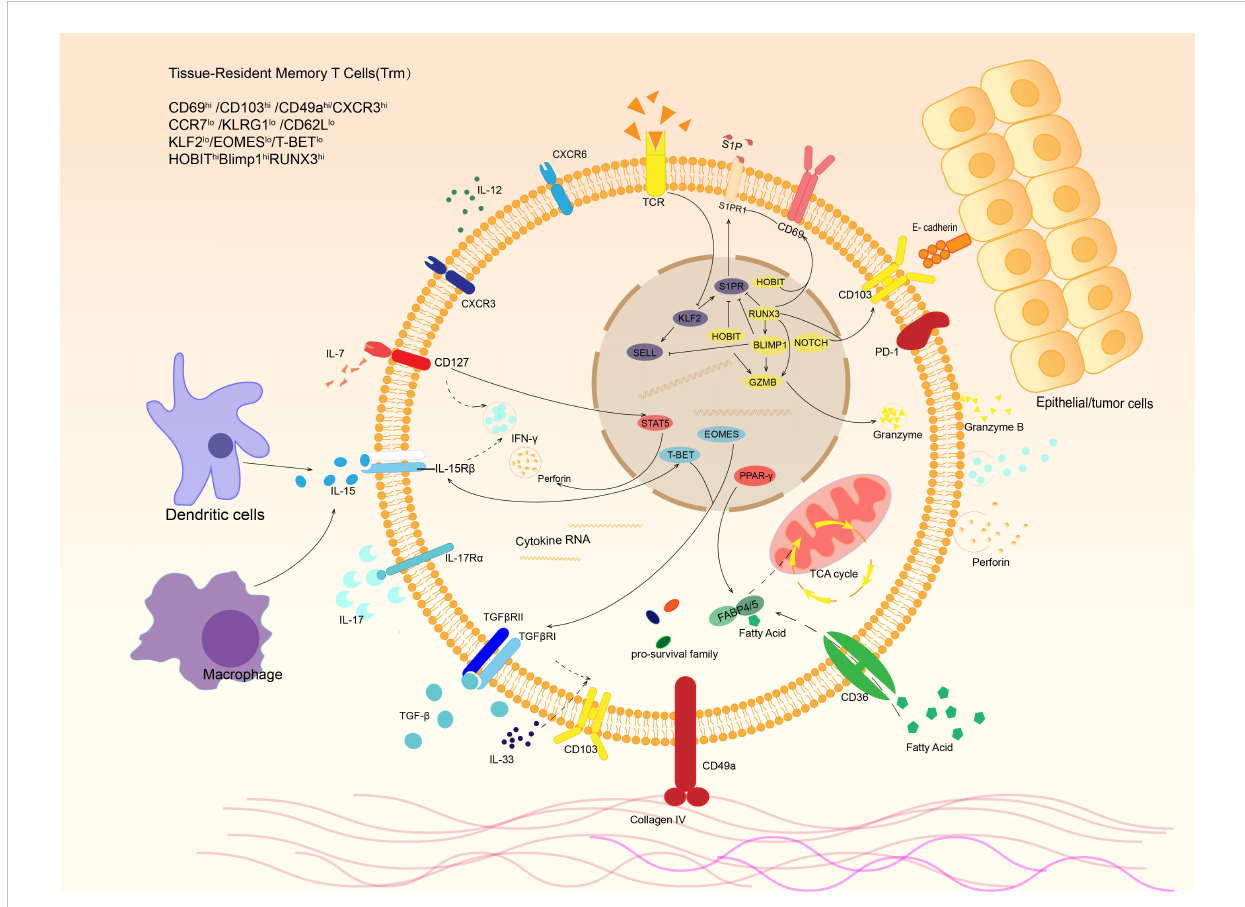
FIGURE 2 Phenotypes and signaling pathways of tissue-resident memory T cells. Trm cells express distinct phenotype under stimulation of various cytokines in tumor microenvironment. For example, dendritic cells and macrophages can release IL-15, which binds to IL-15 receptor and activates transcription factor T-bet, resulting in IFN- g expression of Trm. In response to IL-7 in tumor microenvironment, STAT5 is activated and leads to IFN- g and perforin production. E-cadherin expressed by other cells and extracellular matrix like collagen IV are also able to bind the receptors expressed on Trm surface. After that, they release a variety of cytokines to kill targeted cells and regulate local immune